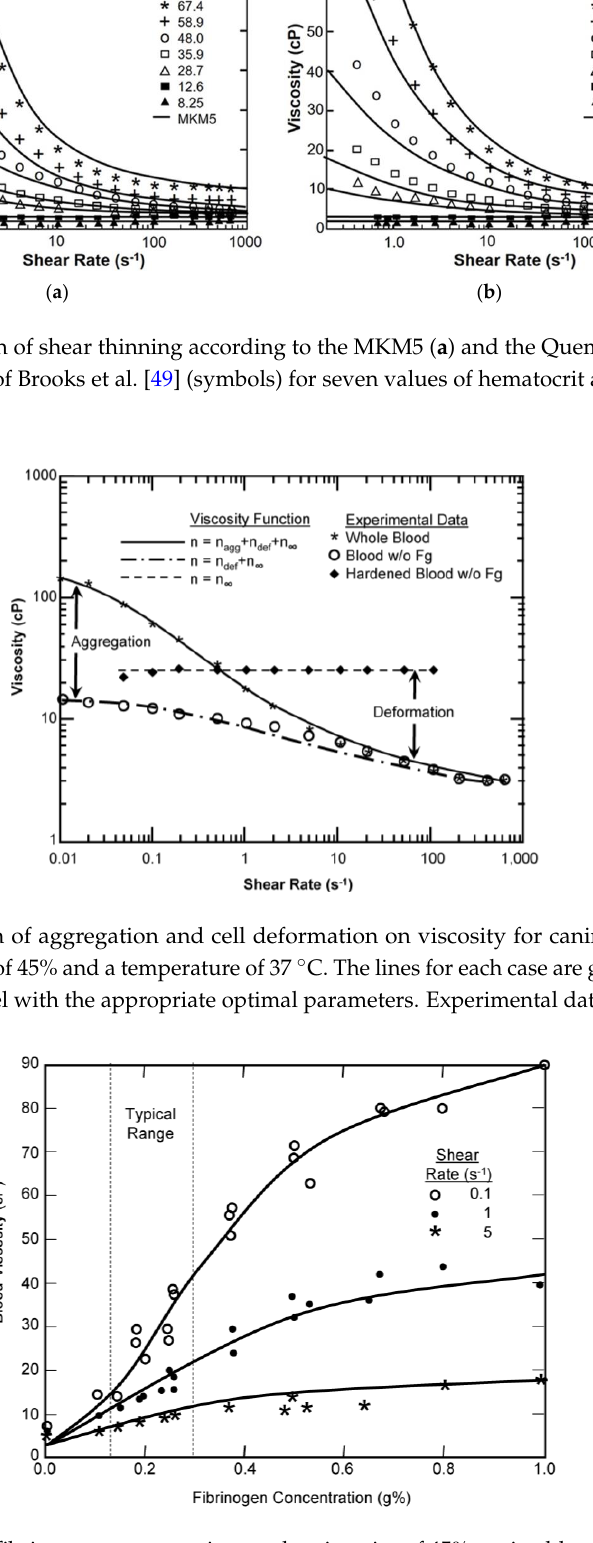
Figure 5. The effect of fibrinogen concentration on the viscosity of 45% canine blood at a temperature of 37 °C. Comparison of experimental data from Chien [23] with the modified Krieger model.